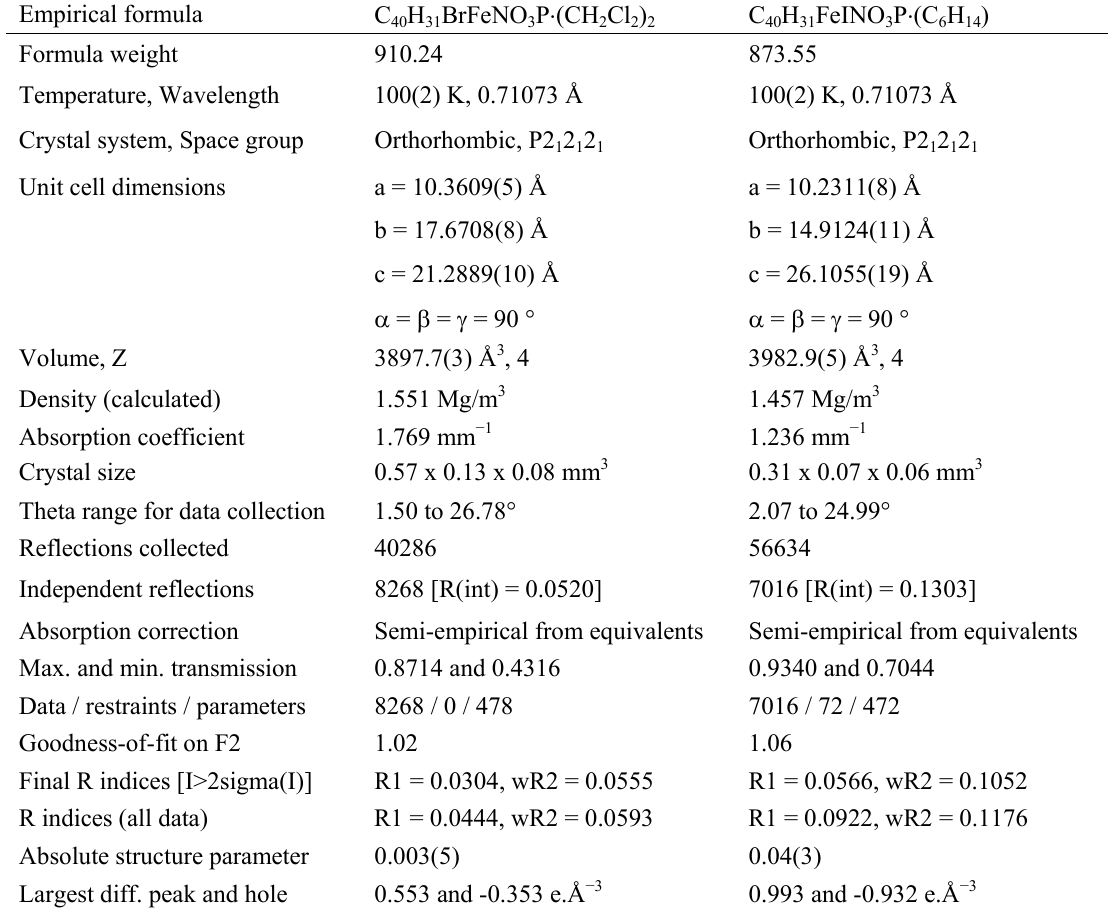
Table 1. Crystal data and structure refinement for 4b and 5b .